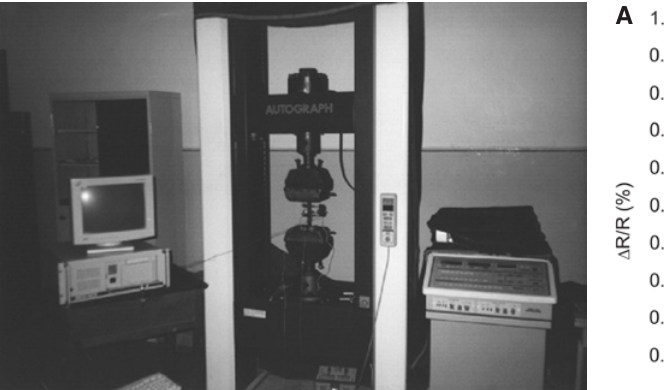
Figure 7: Experimental setup of tension-tension testing.